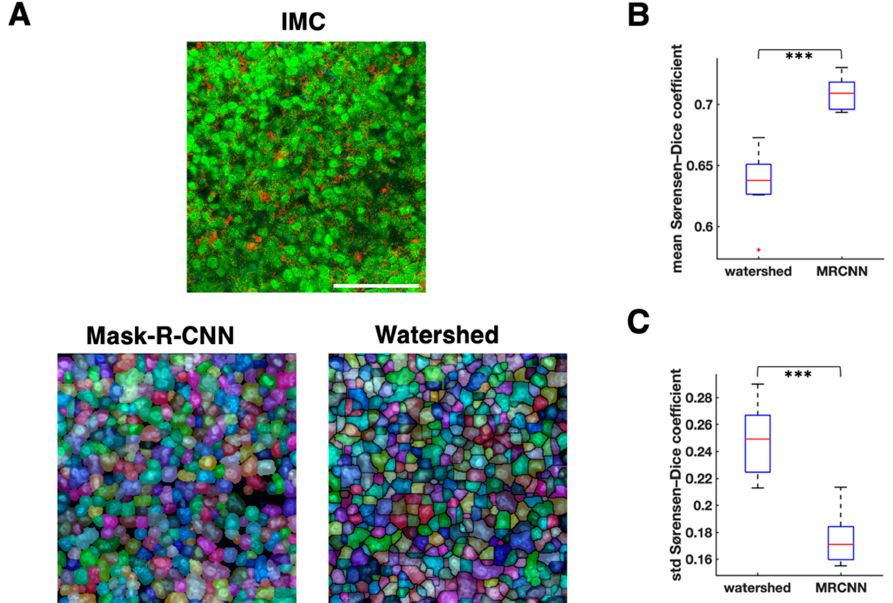
Figure 2. Comparison between watershed and mask-R-CNN cell segmentation. ( A ) . Cell segmentation comparison on one representative image. Top, imaging mass cytometry (IMC) image; red: Keratin8/18, green: histone H3, blue: CD45. Bottom left, mask-R-CNN segmentation (transparent segmentations with pseudo colors are placed over nucleus image). Bottom right, watershed segmentation (transparent segmentations with pseudo colors are placed over nucleus image). White scale bar, 100 µm. ( B ) . Mean Sørensen–Dice coefficient comparison between watershed and mask-R-CNN (MRCNN) with the reference segmentation drawn manually ( n = 10 images, 300 cells segmented per image on average, paired t test). ( C ) . Standard deviation of Sørensen–Dice coefficient comparison between watershed and MRCNN with the reference segmentation drawn manually ( n = 10 images, 300 cells segmented per image on average, paired t test). *** p < 0.001.